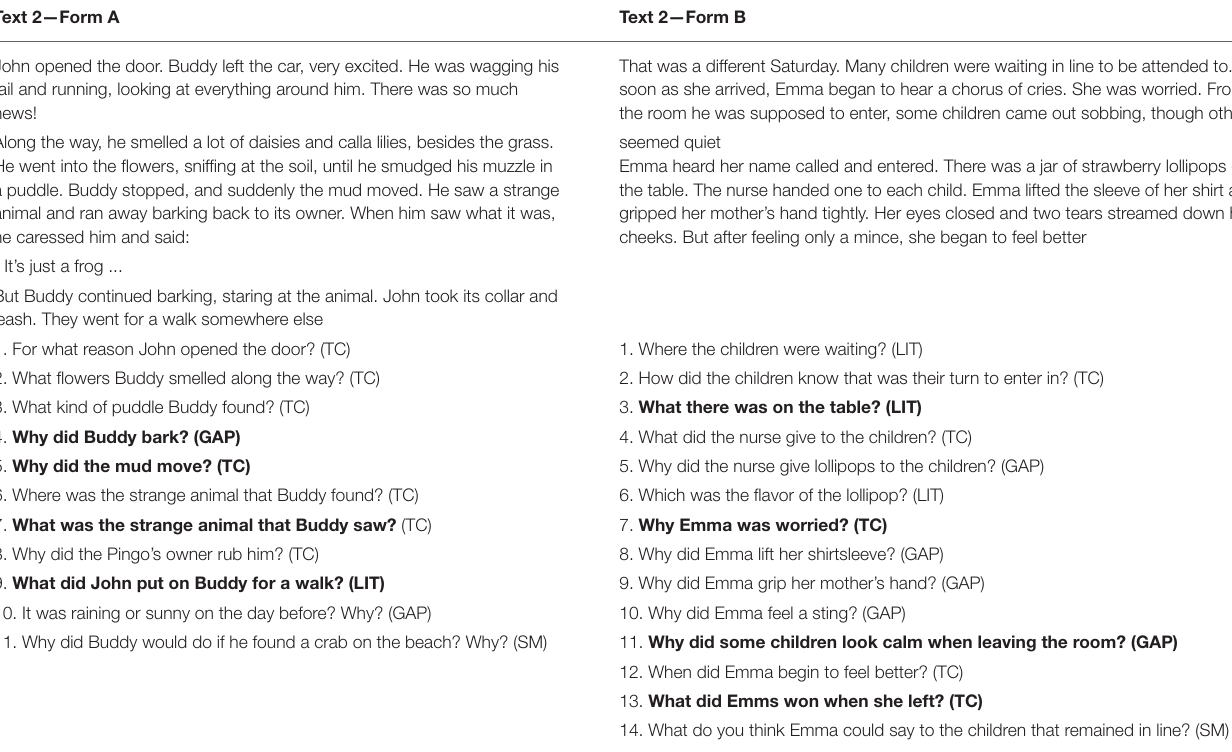
TABLE 3 | Example of texts and related questions in each form (translation). Text 2—Form A Text 2—Form